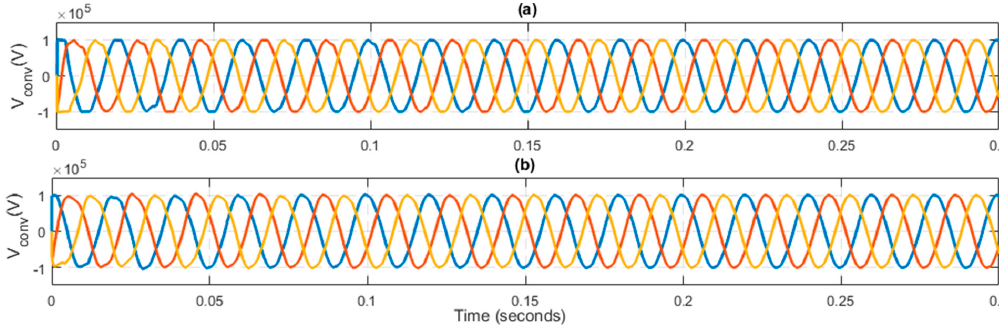
Figure 9. Converter output voltage ( a ) Proposed controller; ( b ) PR controller.